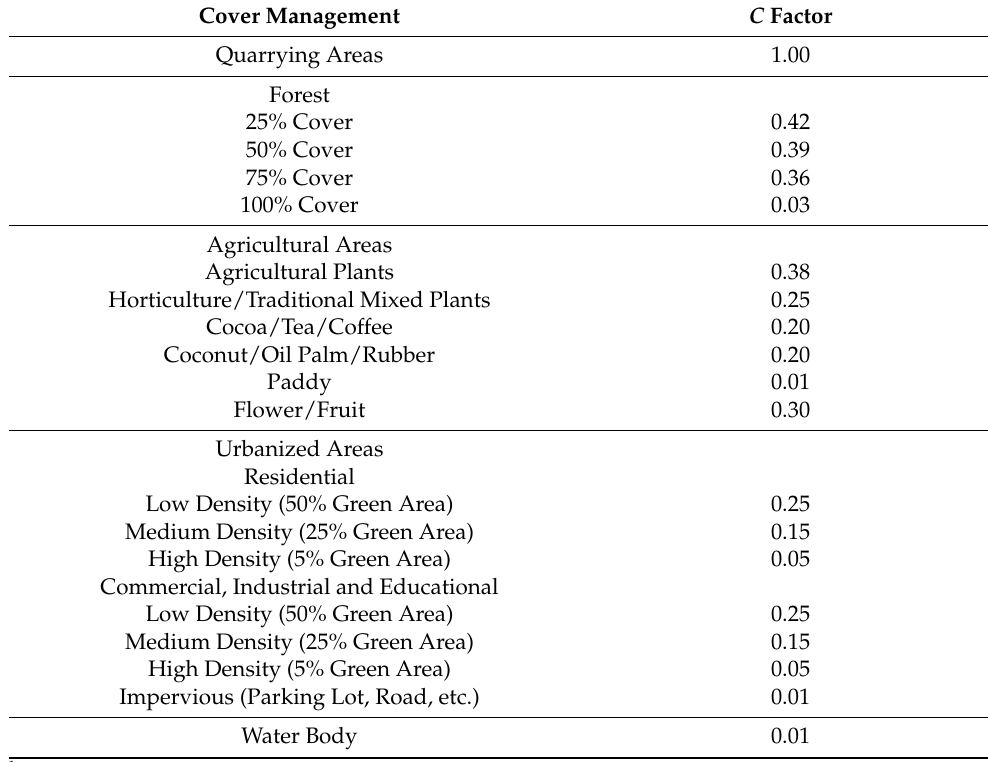
Table 2. Cover Management, C factor for Agricultural, Forested, Urbanized Areas and Undisturbed Land 1 (adapted from Refs. [25–30]).